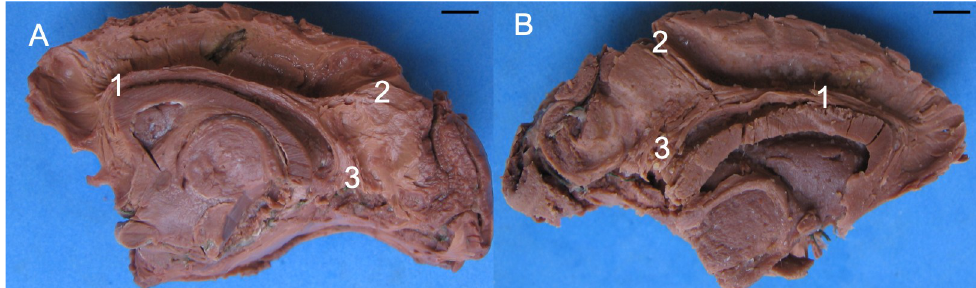
Fig 4. (A) Photograph of the left side of the total brain of Sapajus sp. illustrating the approximate locations of the cingulate-longitudinal fascicles. The longitudinal fascicle reaches the parietal lobe. Note the high lissencephaly in the frontal and occipital lobes. (B) Photograph of the medial part of a non-prepared hemisphere where the cingulate- longitudinal fascicles enter the white matter. [1] Cingulate and longitudinal fascicles in the same bundle; [2] Individualized longitudinal fascicle; [3] Individualized cingulate fascicle. [4] Corpus callosum; [5] Fornix; [6] Thalamus; [7] Frontal pole; [8] Occipital pole. Specimens: (A) adult male; (B) adult female. Bar = 1 cm.